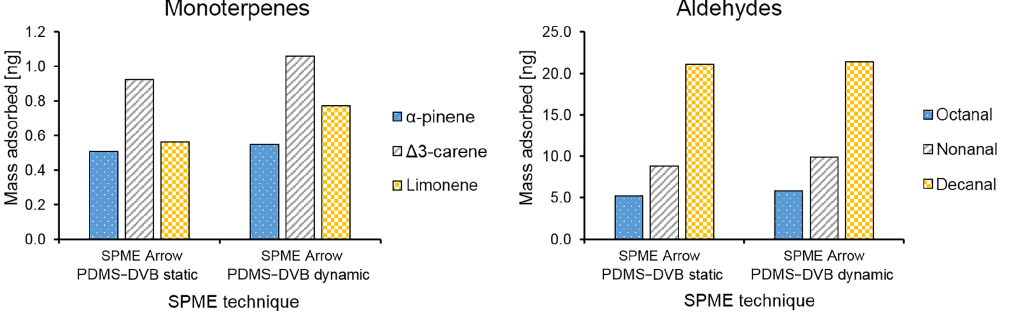
Figure 8. Comparison between the average mass of identified monoterpenes ( α -pinene, (cid:49) 3 -carene, and limonene) and aldehydes (octanal, nonanal, and decanal) collected with different sampling modes (static and dynamic) by SPME Arrow (PDMS–DVB) from ambient air and measured by GC-MS.